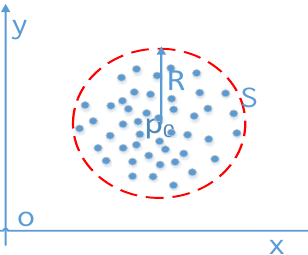
Figure 12. Particle initialization area based on long trajectory matching result.